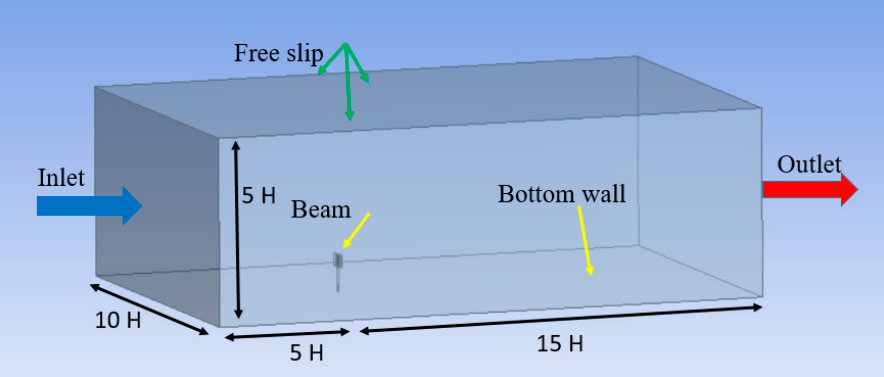
Figure 6. Details of the computational domain and boundary conditions.